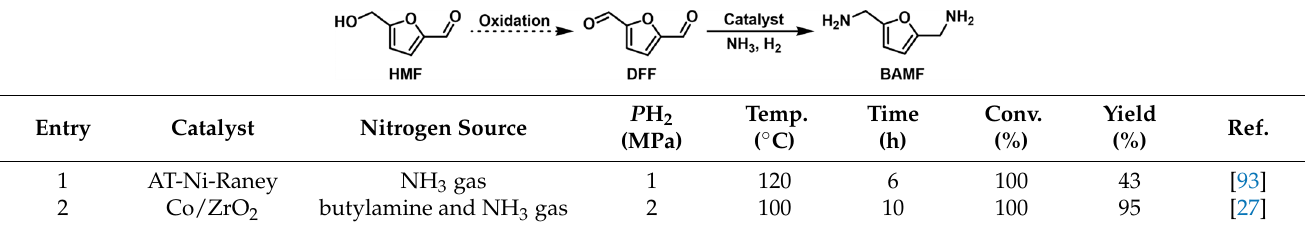
Table 5. The reductive amination of DFF with NH 3 .